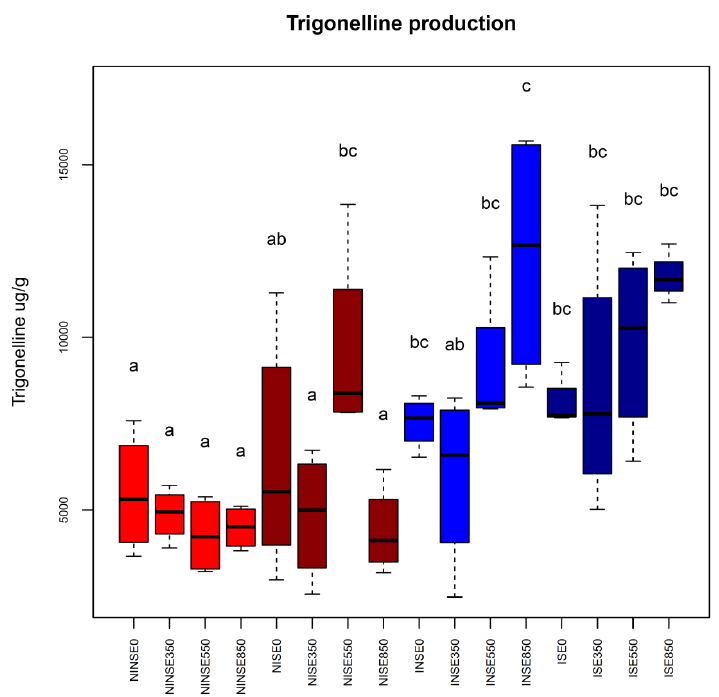
Figure 1. Boxplots representing trigonelline production in the di ff erent conditions (NI, I: not-inoculated and inoculated plants, respectively; S, NS: water stressed and non-stressed plants; E0, E350, E550, E850: di ff erent ethephon concentrations in ppm). Di ff erent conditions were color coded as follows: red and brown boxes represent not-inoculated plants (NI) non-stressed (NS) and water stressed (S), respectively; blue and dark-blue boxes represent inoculated plants (I) non-stressed (NS) and water stressed (S), respectively. Letters are plotted according to outcomes of Tukey’s